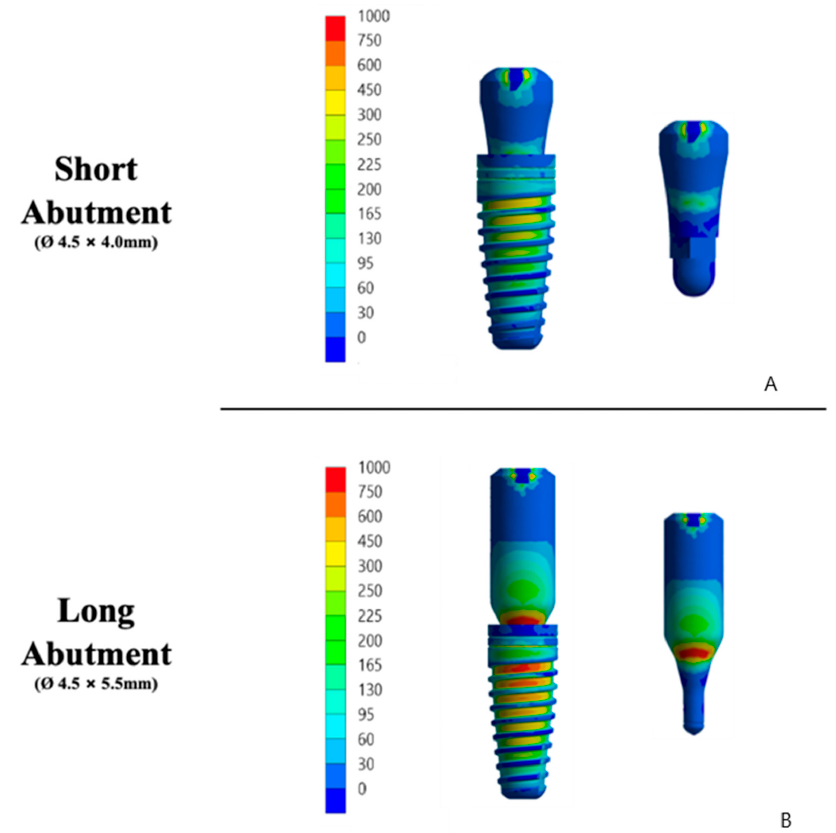
Figure 8. Illustrative of the 3D modeling of the qualitative analysis of maximum principal stress and von Mises (Mpa) criteria on the implant/abutment ( left ) and abutment ( right ) of each group. ( A ) Short abutment. ( B ) Long abutment.